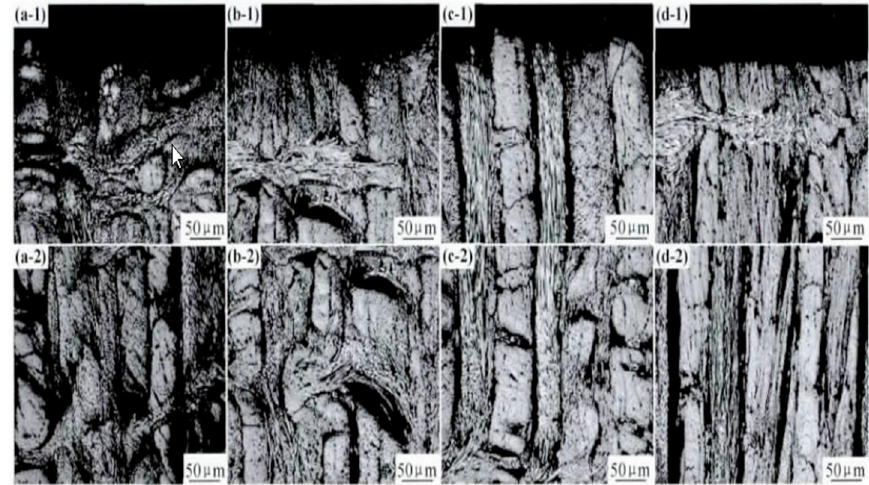
Figure 11. Surface morphology of the non-friction side and substrate of carbon–carbon materials with di ff erent surface hardness. ( a-1 , a-2 ) HS40; ( b-1 , b-2 ) HS50; ( c-1 , c-2 ) HS60; ( d-1 , d-2 ) different surface hardness. ( a ) HS40; ( b ) HS50; ( c ) HS60; ( d ) HS70